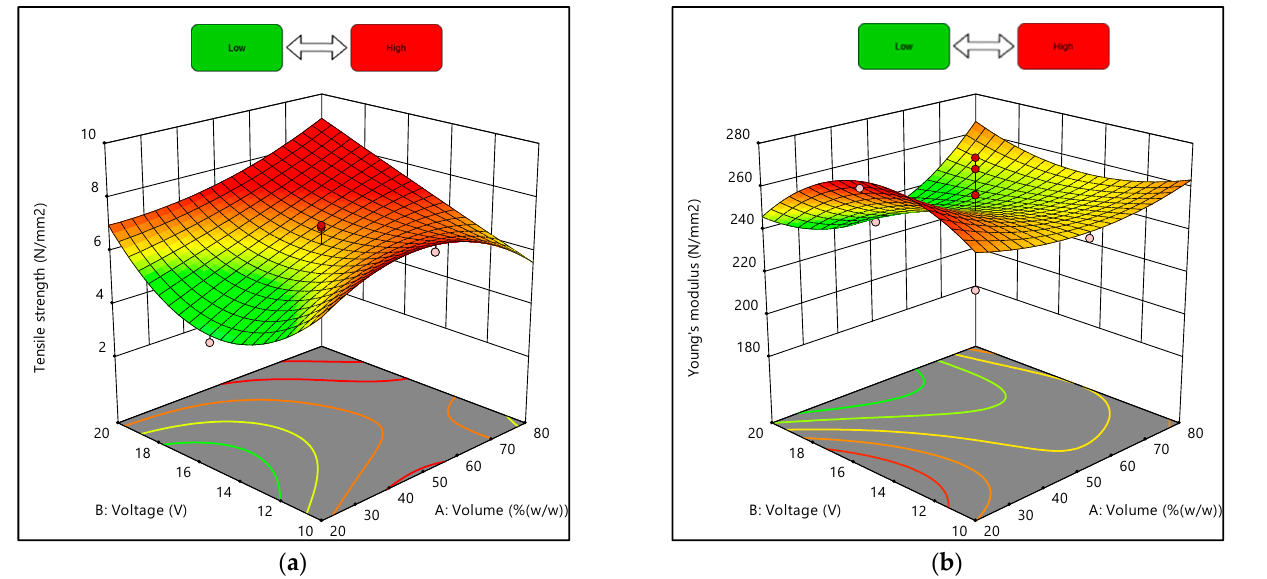
Figure 8. Three-dimensional response surface plots for experimental designs of 20% and 80% water: ( a ) Tensile strength, ( b ) Young’s modulus.